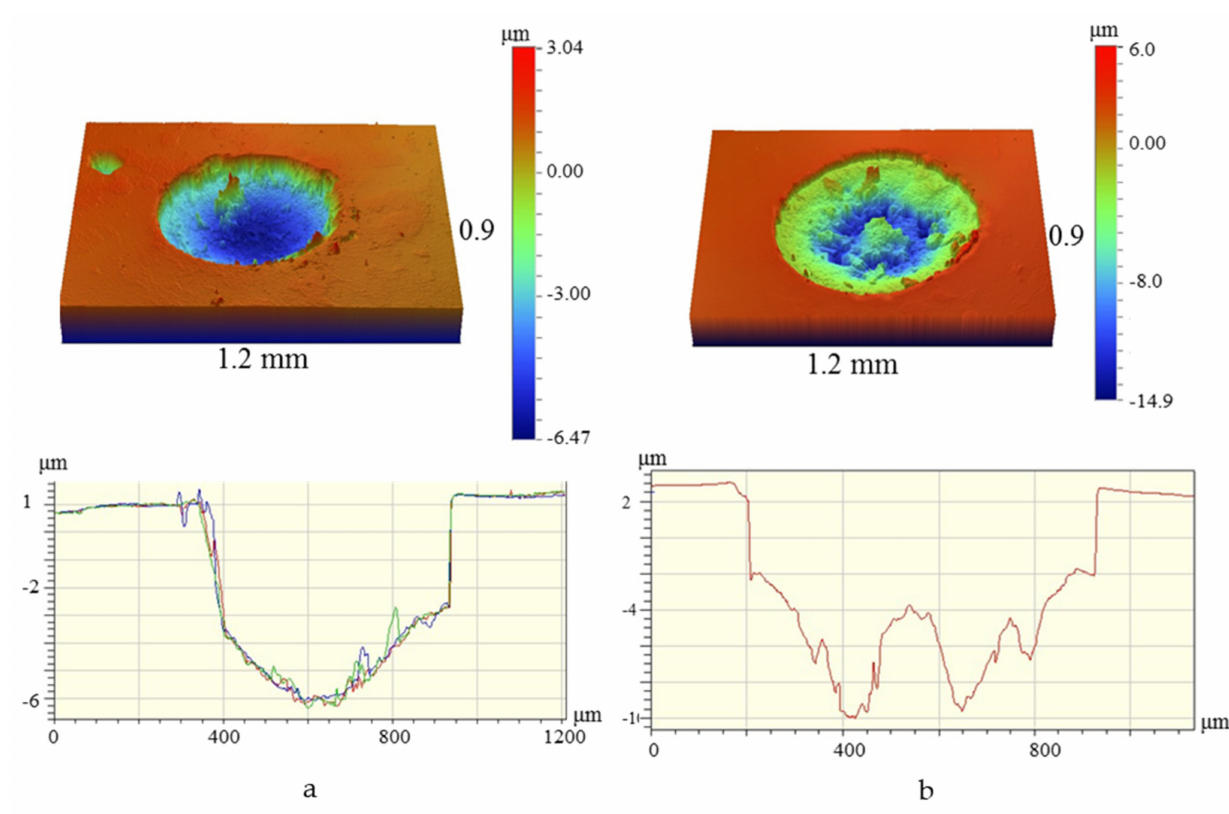
Figure 8. 3D and 2D profiles of wear holes for the coatings 1 (100%Ar) ( a ) and 2 (85%Ar + 15%N 2 ) ( b